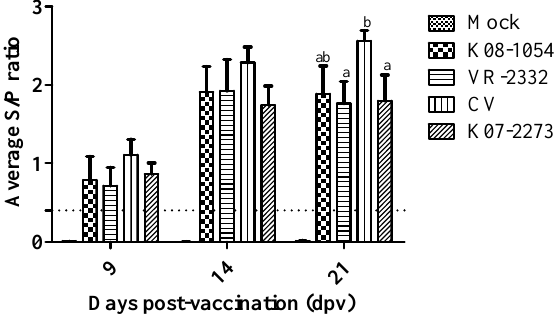
Figure 5. Antibody titers of vaccinated pigs measured by PRRS ELISA. The 0.4 S/P ratio represents the threshold value designated by a dashed line. Bars showing different letters represent values significantly different from each other ( p < 0.05).